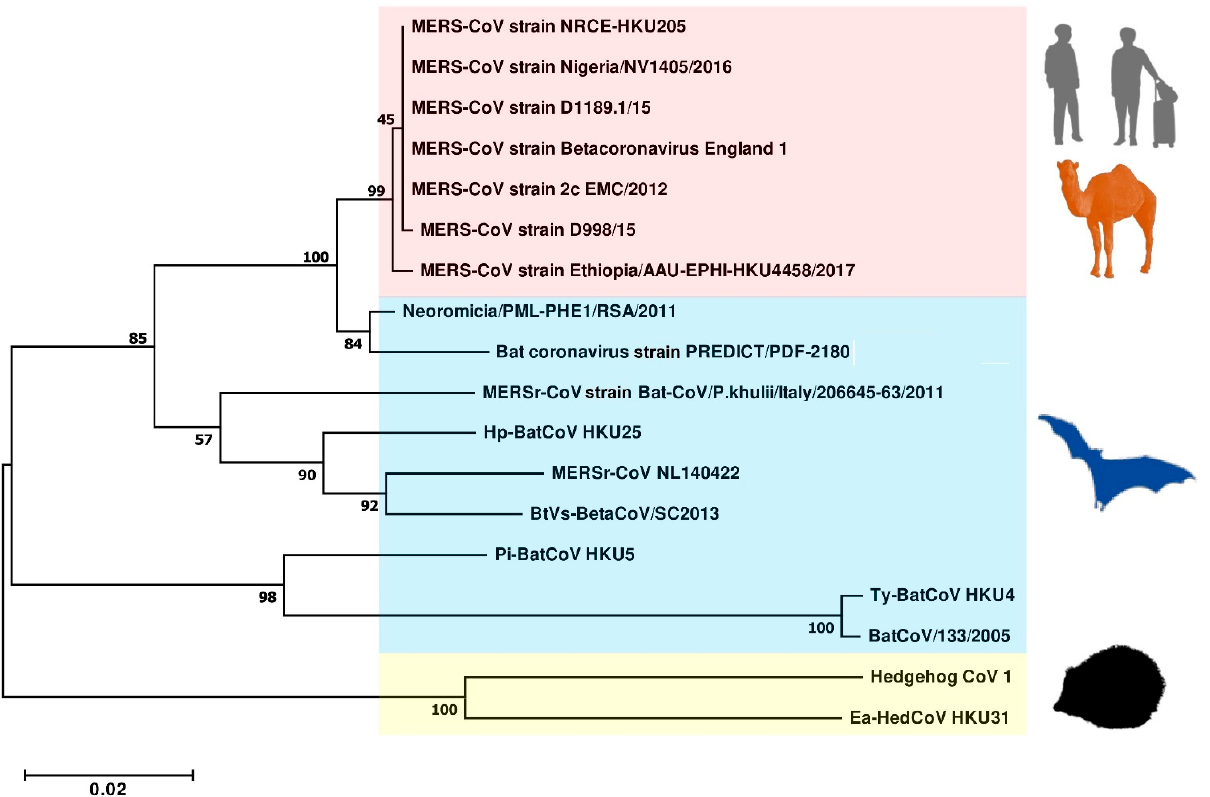
Figure 4. Maximum-likelihood phylogeny based on the nsp12 amino acid sequences of selected MERSr-CoVs and merbecoviruses. A Jones – Taylor – Thornton (JTT) model of amino acid substitution was used in the analysis with a discrete gamma ( γ ) distribution. 1000 trees were set for bootstrap values calculation. All bootstrap values and the scale bar indicating the number of amino acid substitutions per site are shown. Viral strains highlighted in red color represents the MERSr-CoV cluster, blue color represents the bat merbecoviruses cluster, yellow color represents the hedgehog merbecoviruses cluster.